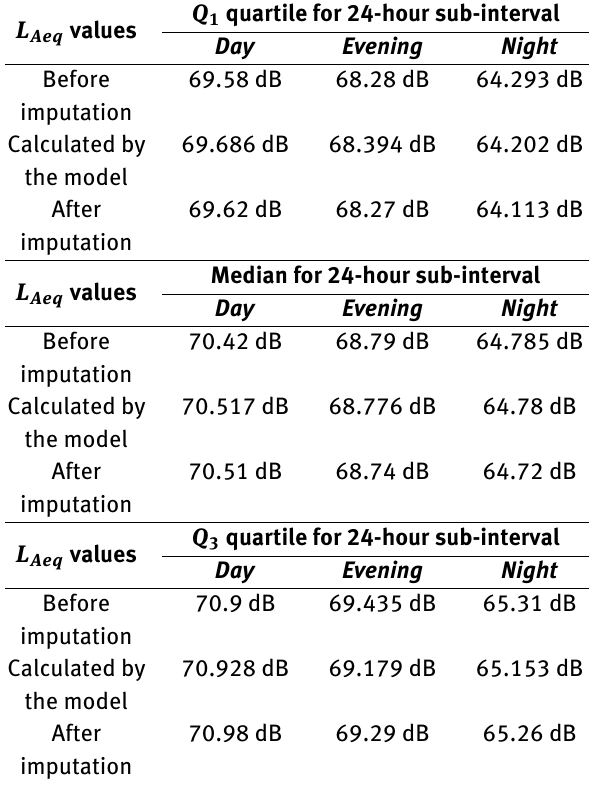
Table 2: Selected parameters of the model at location no. 1 [1] Q 1 quartile for 24-hour L Aeq values